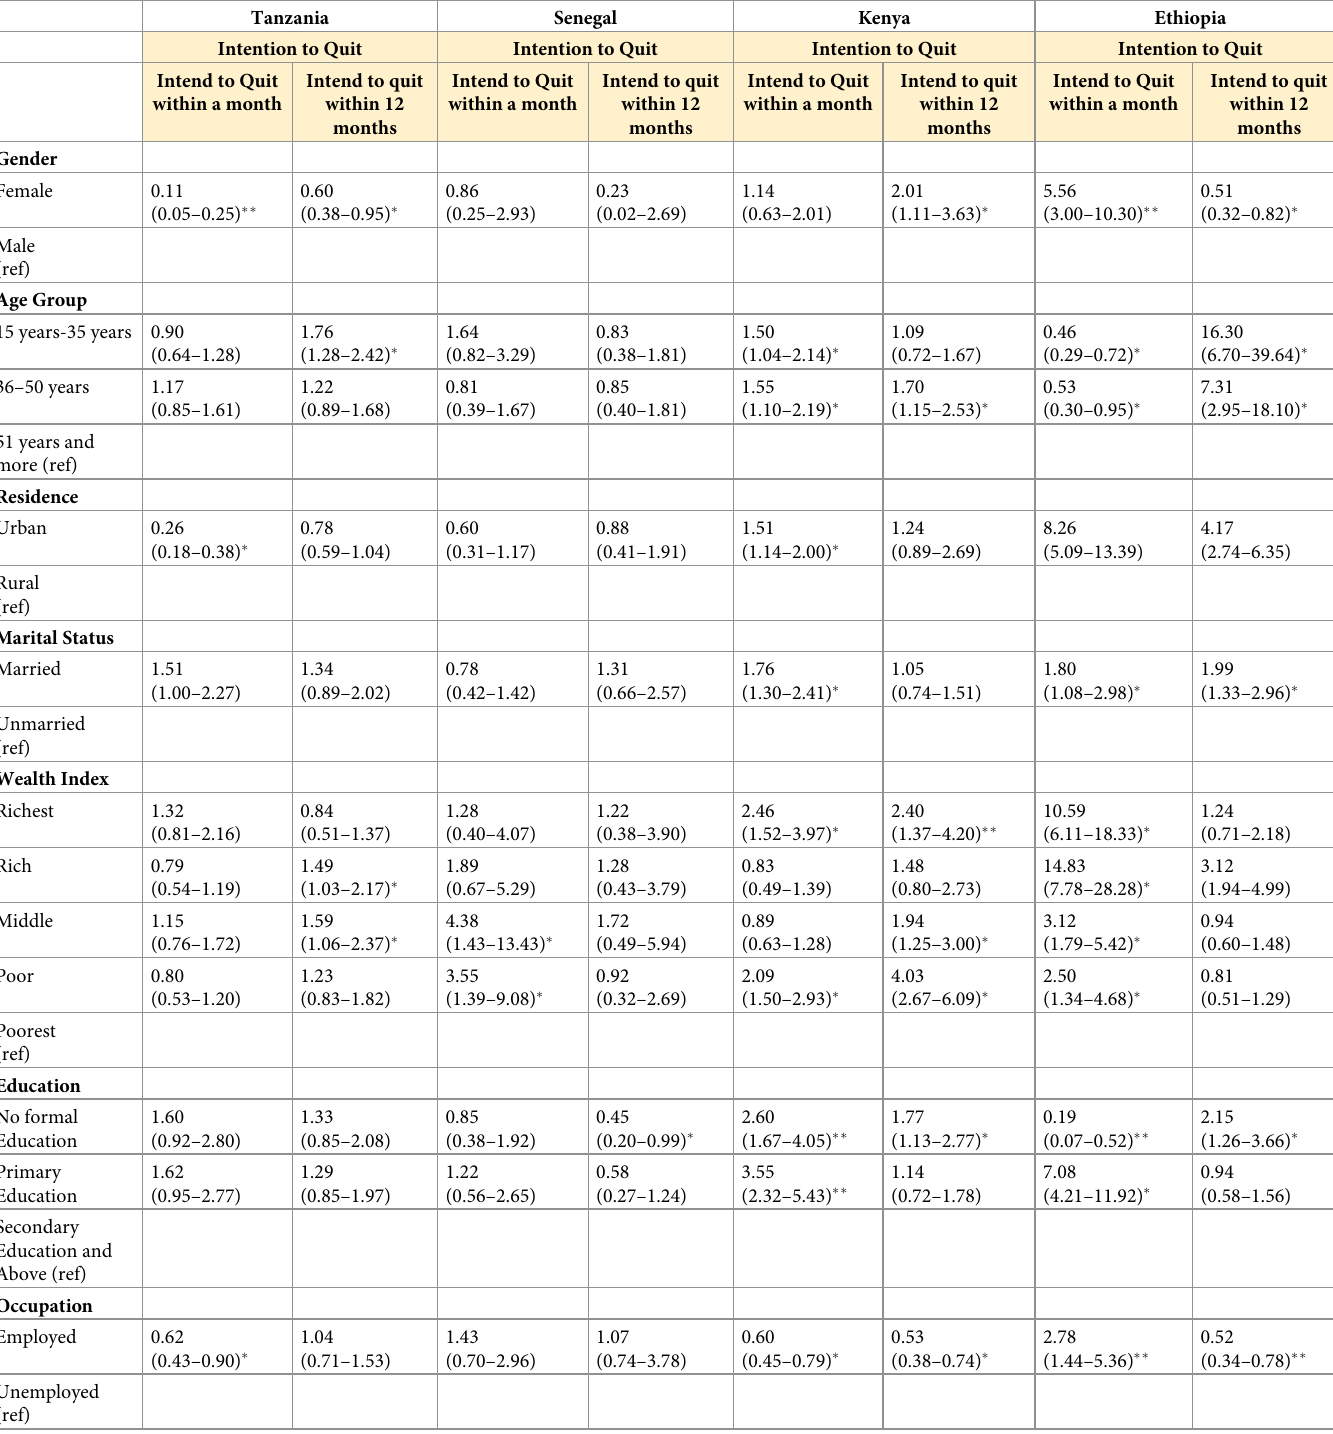
Table 3. Socio-economic factors associated with intention to quit across the four African countries.